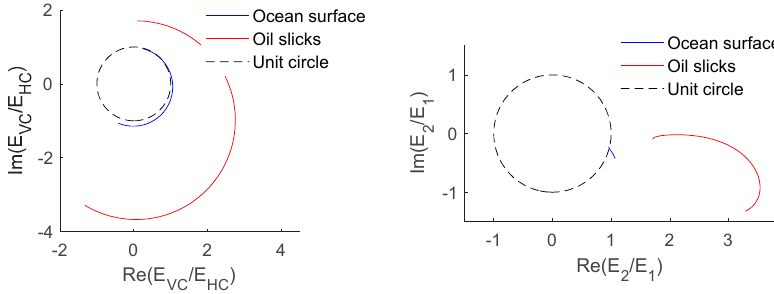
Figure 1. Schematic representation of 𝐸(cid:4652)⃑ (cid:3045) and 𝑘(cid:4652)⃑ (cid:2869) .